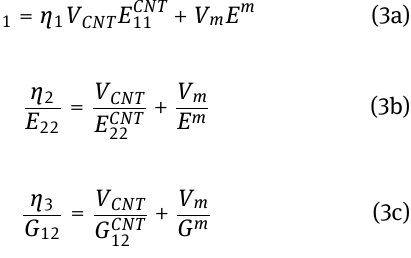
surface of the panel such that z = − h /2 and z = h /2 repre- sent the top and bottom surfaces of the panel,